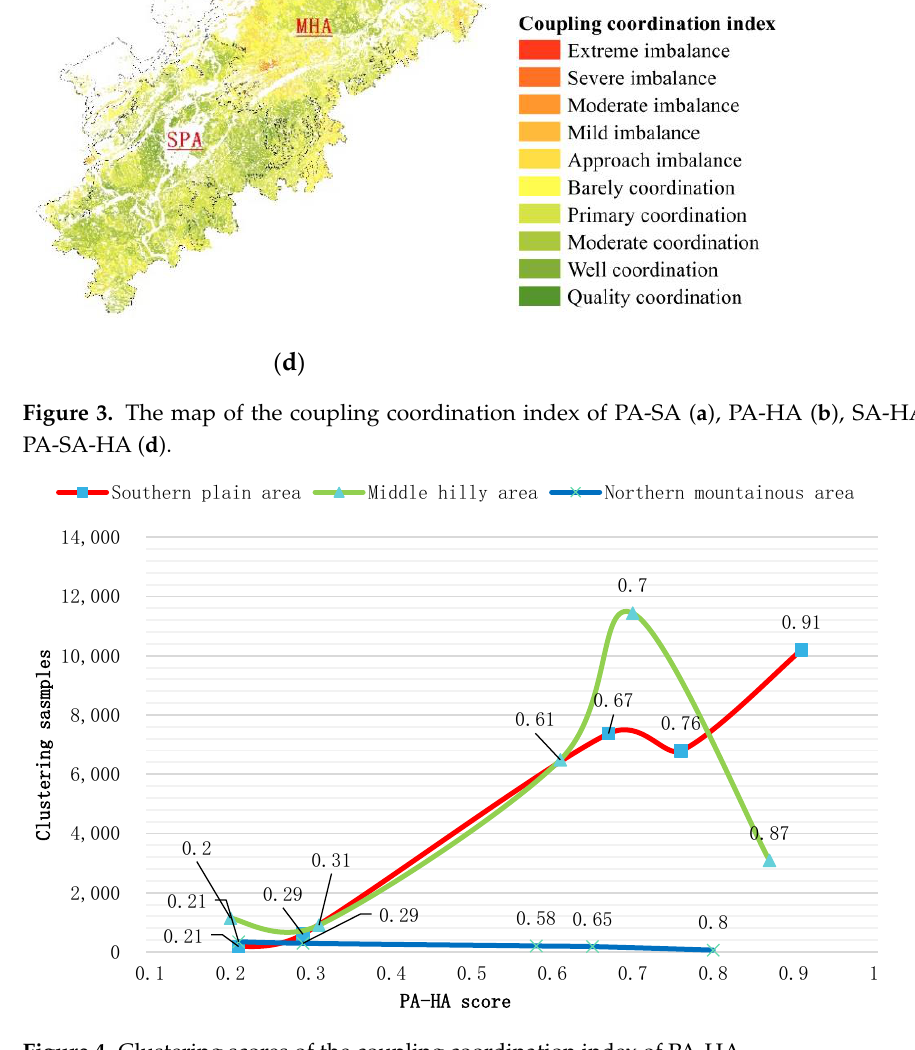
Figure 4. Clustering scores of the coupling coordination index of PA-HA.